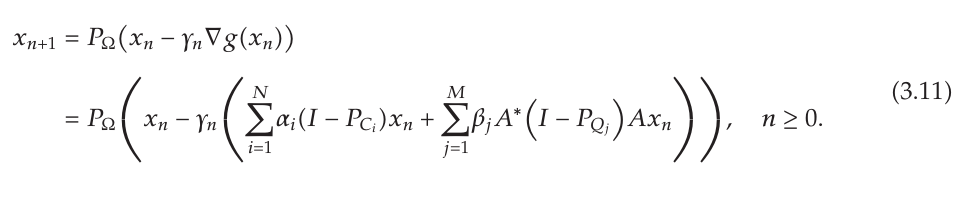
Algorithm 3.11. Gradient-projection algorithm